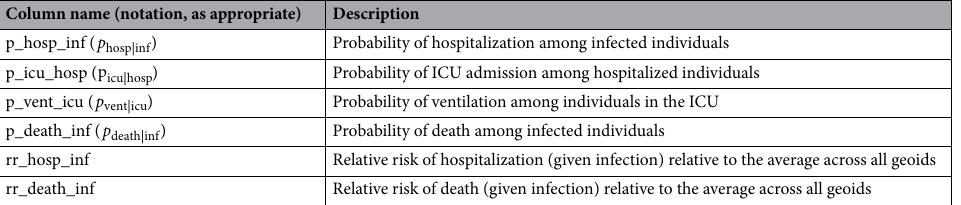
Table 1. Health outcome risk